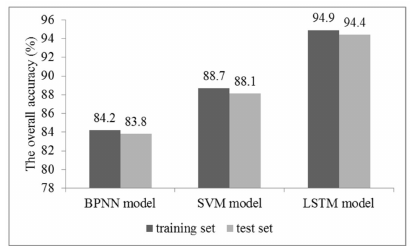
Figure 5. Prediction accuracies of different models (prediction scale: one week). BPNN: backpropagation neural network. SVM: support vector